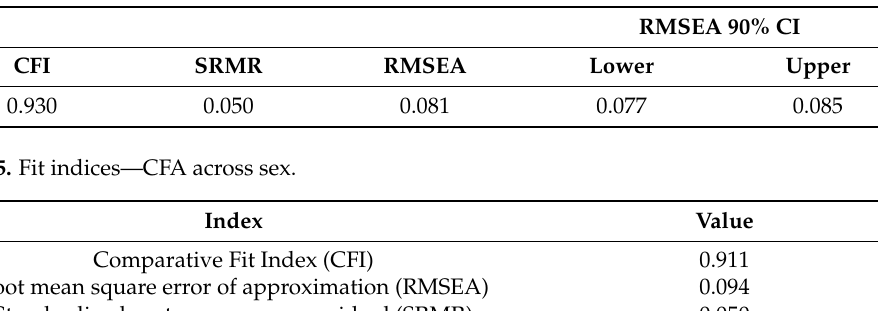
Table 4. Fit Measures with Modification Indices.